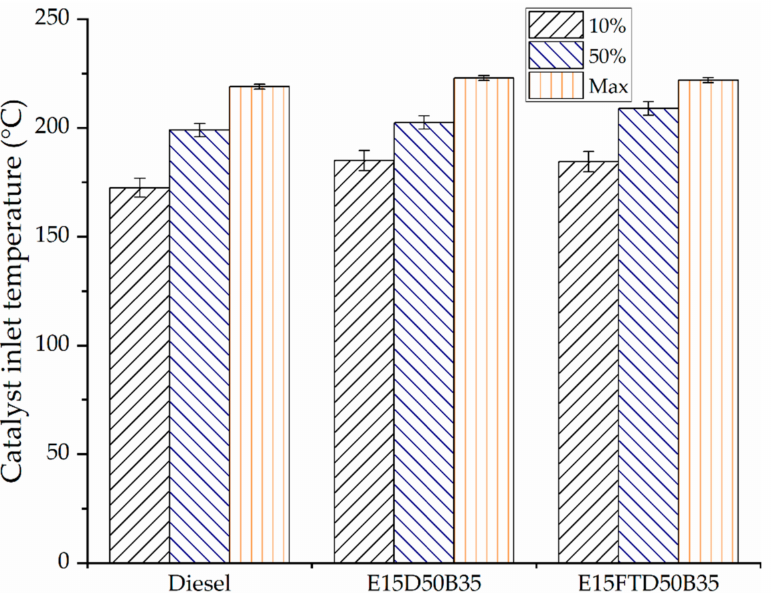
Figure 8. Diesel oxidation catalyst (DOC) inlet temperature that was required to reach 10%, 50%, and maximum CO conversion for diesel, E15D50B35, and E15FTD50B35 at 2 bar IMEP and 1500